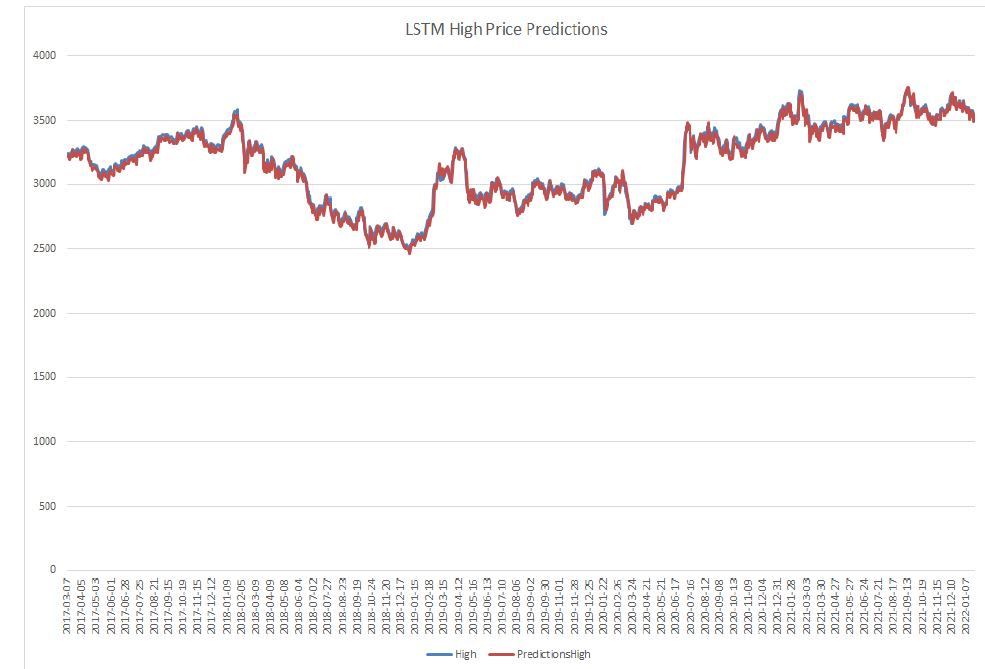
Figure 17. LSTM model high price